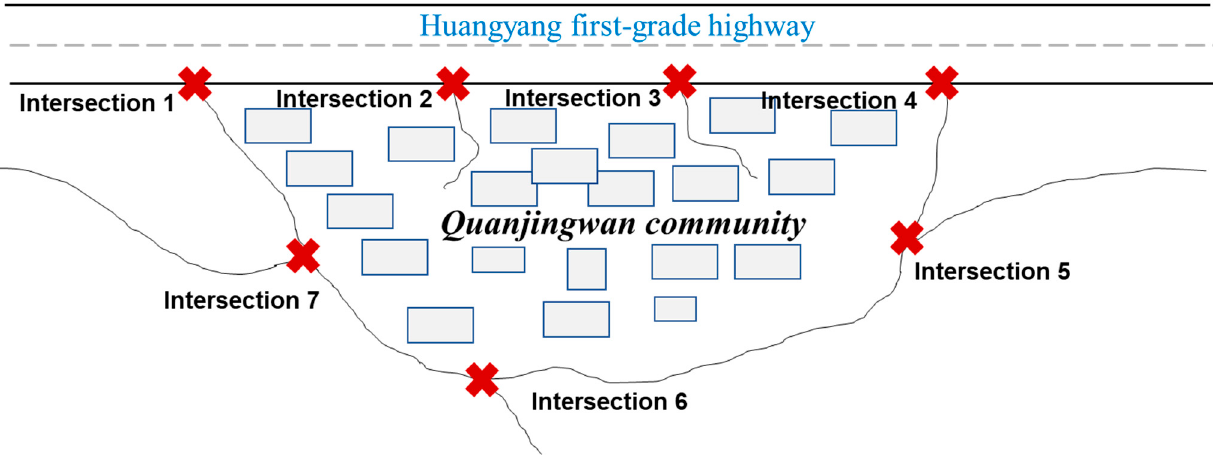
Figure 2. Road intersections around Quanjingwan.